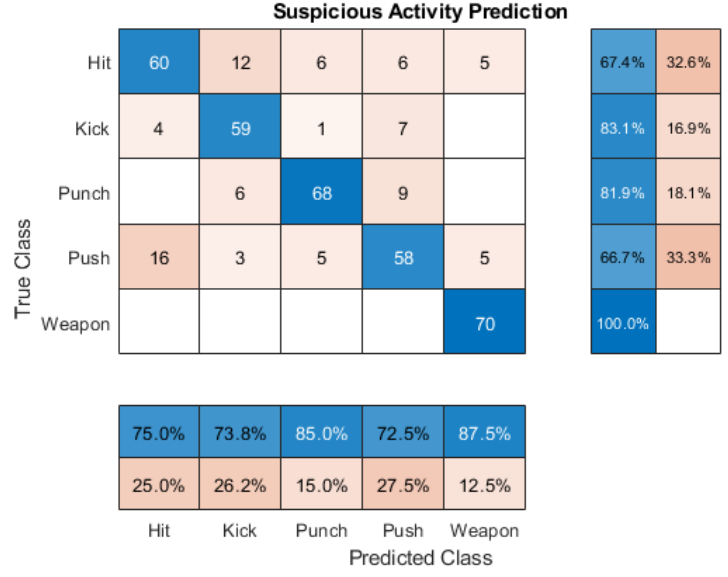
Figure 6. The confusion matrix for performance analysis. Table 5. Classification performance of the GoogleNet–BiLSTM